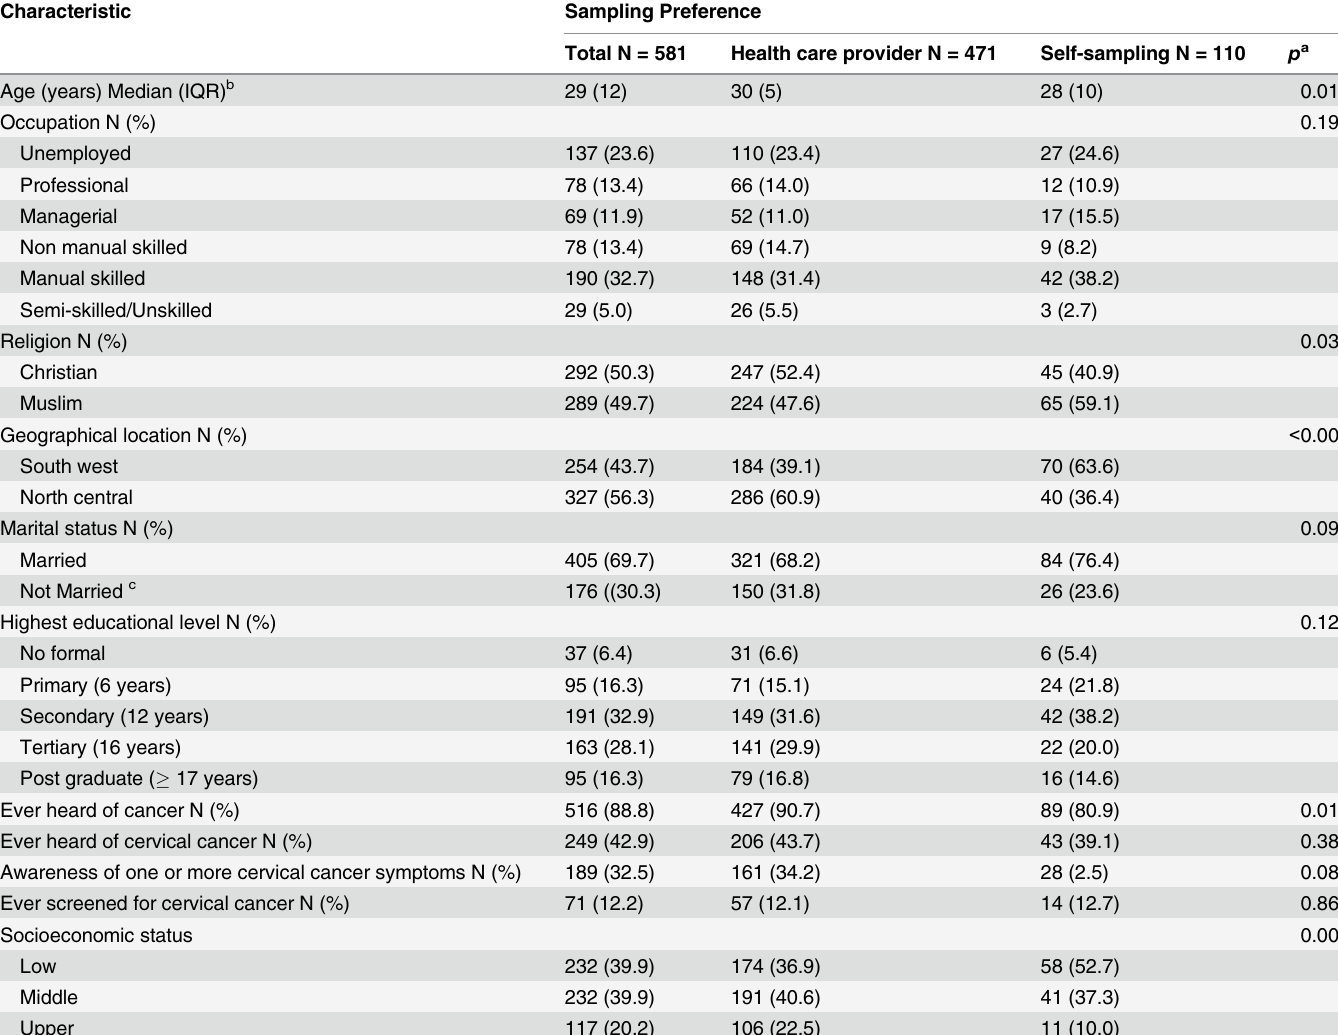
Table 2. Demographic, social characteristics and cervical cancer knowledge of participants by sampling preference, Nigeria, 2014.